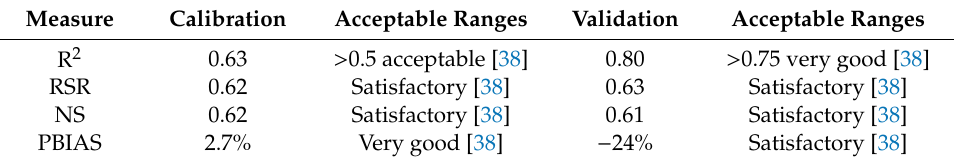
Table 5. The goodness-of-fit indicators for the calibration, at a daily time-step for the period 1960–1999, and the validation, for the period 2000–2008, of streamflow in the Sabor River basin. Symbols: square error to the standard deviation of measured data, and PBIAS—the percent of